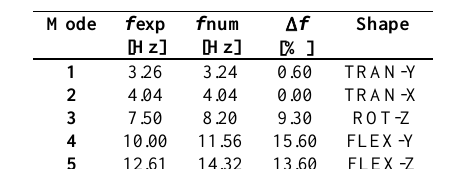
Figure 9. a) Assigned materials at the final model; b) Numerical modal shapes obtain with eigenvalue analysis carried out on the updated model at the last step